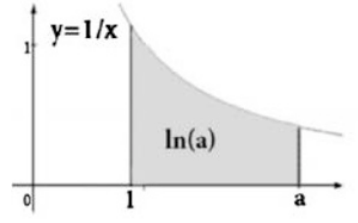
Fig. 1. Illustration of the natural logarithm ln (x) as the area under the hyperbola y = 1/x.